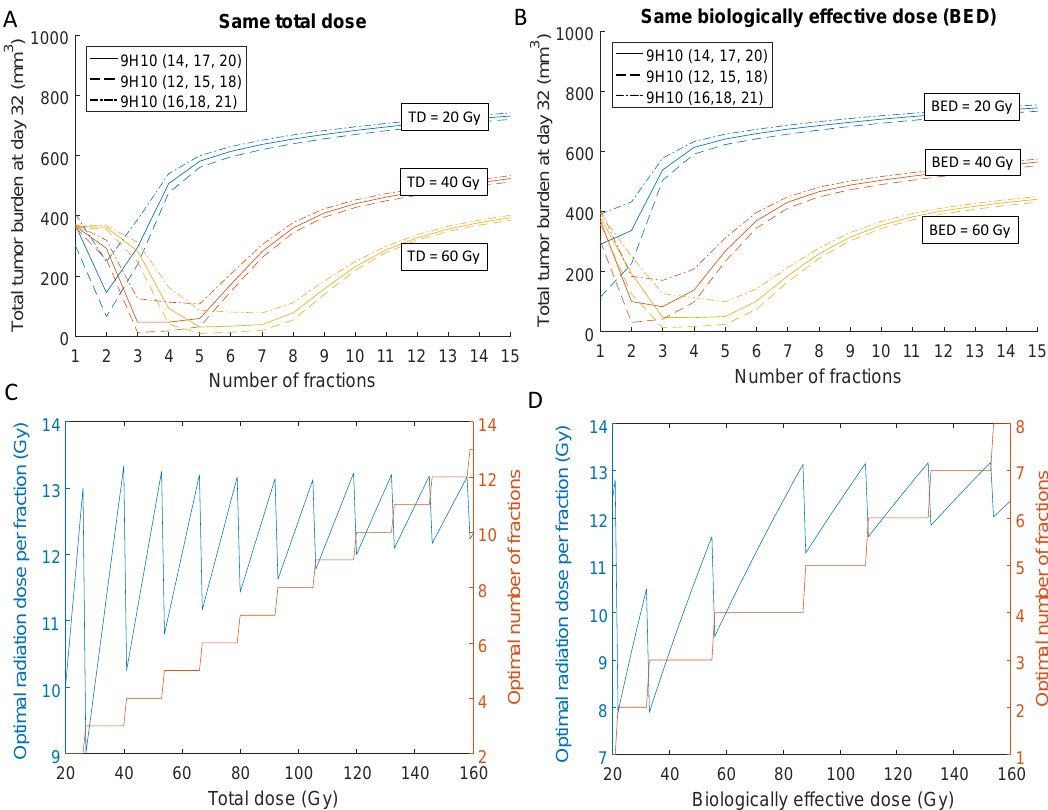
Figure 4. Optimal radiation fractionation and dose per fraction for immune activation. Dependence of the model predicted overall tumor burden at Day 32, i.e., V 1 ( 32days ) + V 2 ( 32days ) , for different total ( A ) and biologically effective doses ( B ) for various numbers of fractions. Radiation is delivered daily, and three concurrent doses of 9H10 immunotherapy are applied at different times [11]. ( C , D ) Optimal number of radiation fractions and corresponding doses per fraction depending on the prescribed total and biologically effective doses. We assume that 9H10 immunotherapy is applied on Days 12,15 and